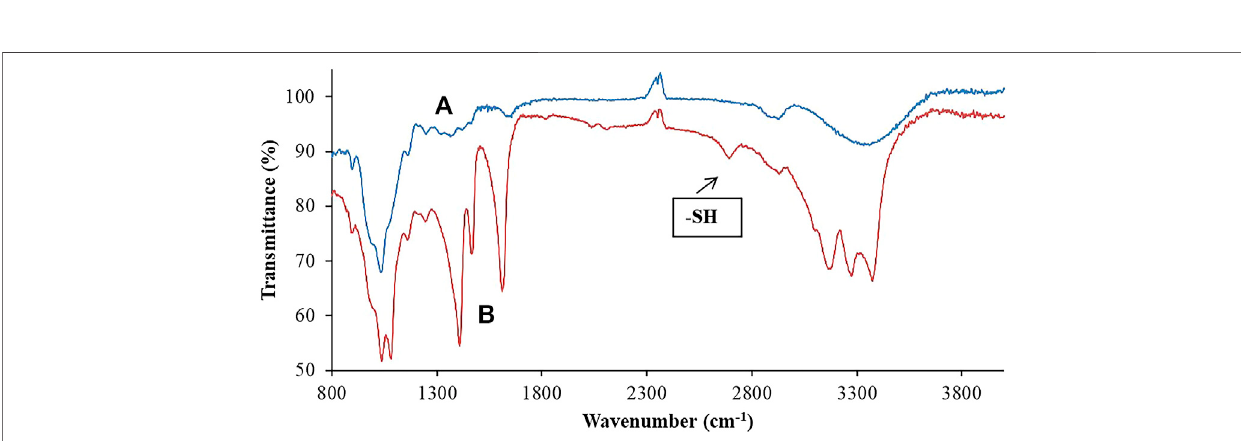
Frontiers in Pharmacology |